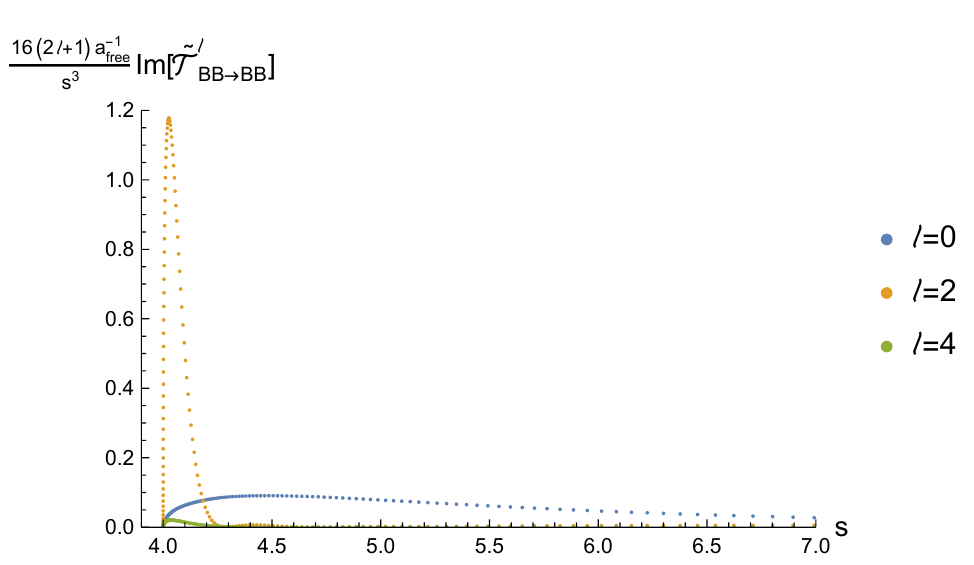
Figure 10 . Integrand appearing in the sum-rule (3.58) for the absolute minimum of the a -anomaly for spin 0, 2 and 4. Numerical integration of this function leads to a/a free = 0 . 2396 + 0 . 1605 + 0 . 0105 + . . . = 0 . 4106 + . . . , where the three entries correspond to spin 0, 2 and 4 respectively and the dots indicate the contribution due to higher spins. Plots are constructed at N max = 20 and L max = 30 . Summing up these three contribution gives the N max = 20 curve of figure